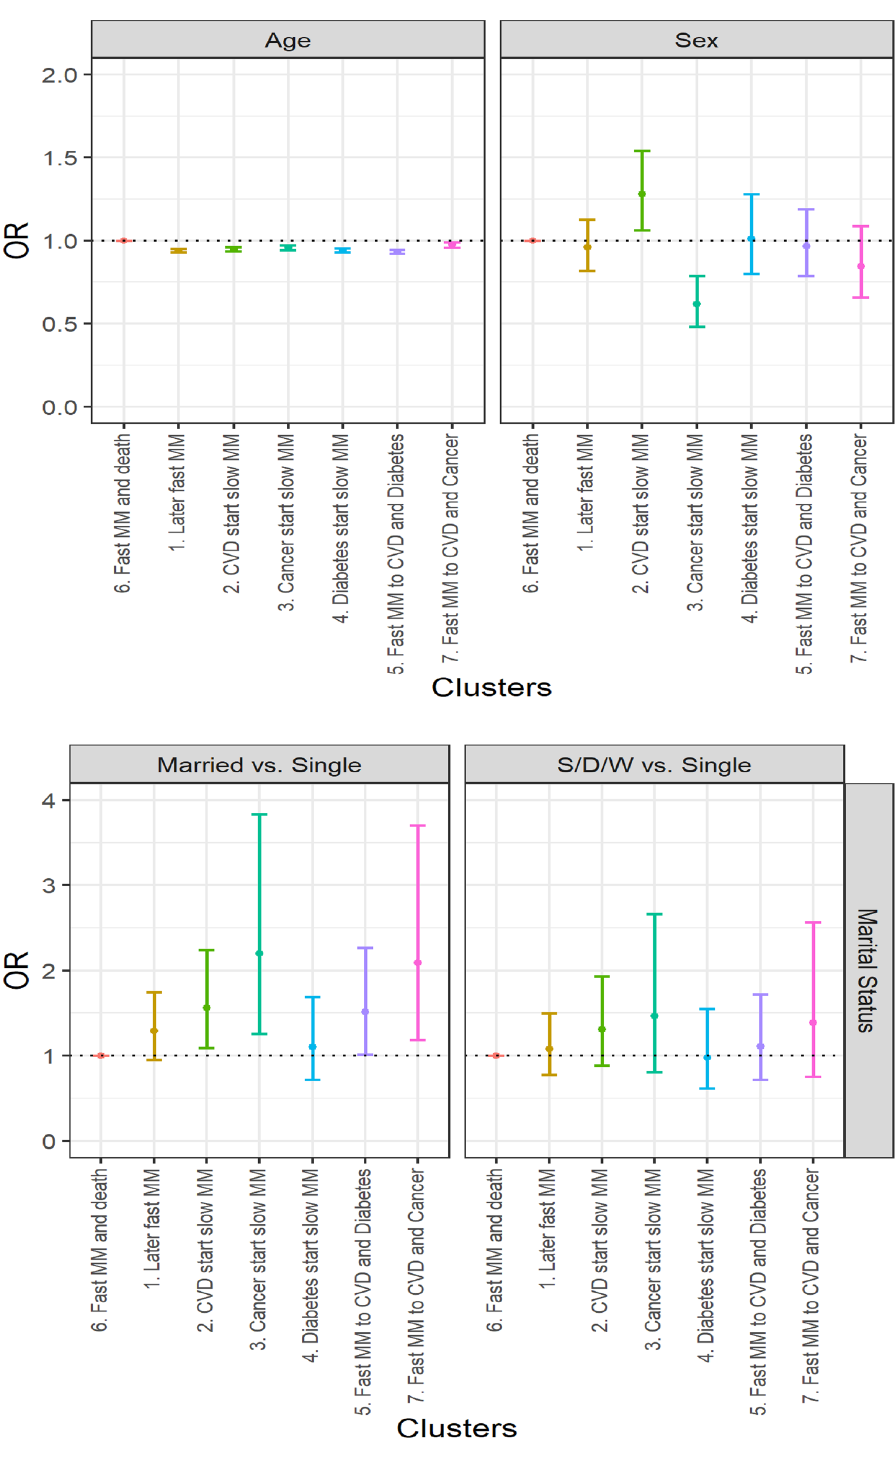
Figure 3. Age- and sex-adjusted socioeconomic differences in typical multimorbidity trajectories. Source: Scottish Longitudinal